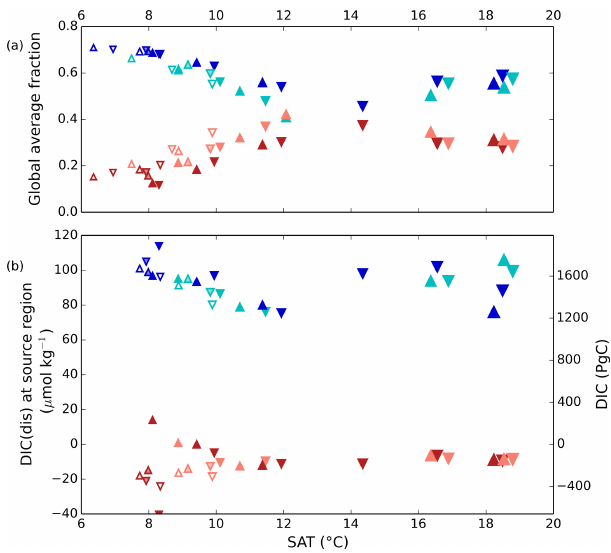
Figure 5. (a) Global average fraction of northern- (reddish colors) and southern-sourced (bluish colors) water. (b) Annual average val- ues of DIC dis of these water masses determined at 25m depth in the model during model years and at locations where deep convection occurs. Pink and cyan (red and blue) symbols represent high (low) obliquity scenarios; triangles pointing upward and downward repre- sent greater Northern and Southern hemisphere seasonality (preces- sion 270 and 90 ◦ ); outlines are scenarios with LGM ice sheets; light shading indicates scenarios with LGM ice sheet topography but PI albedo. Five simulations, for which no deep convection events were identified south of 60 ◦ S, are not shown. The size of the symbols corresponds to the